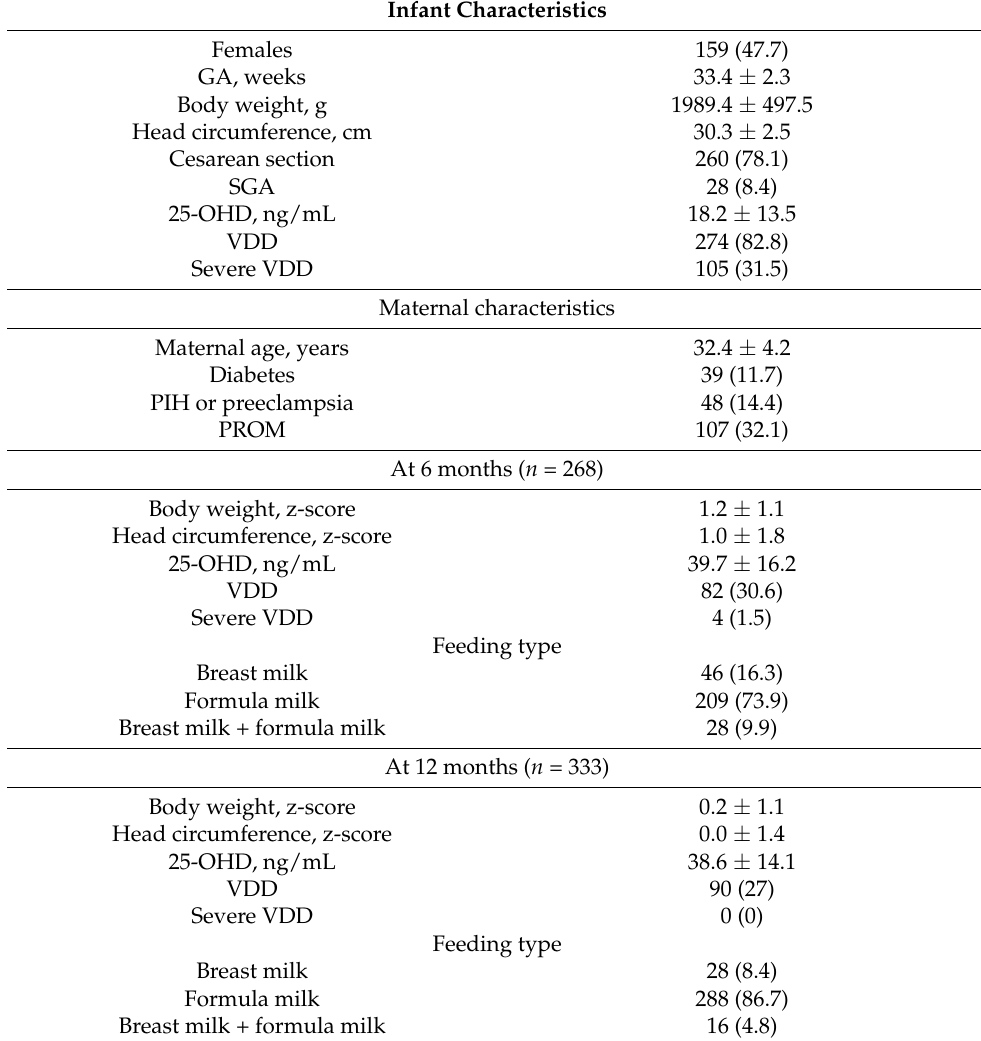
Table 1. Characteristics of the study